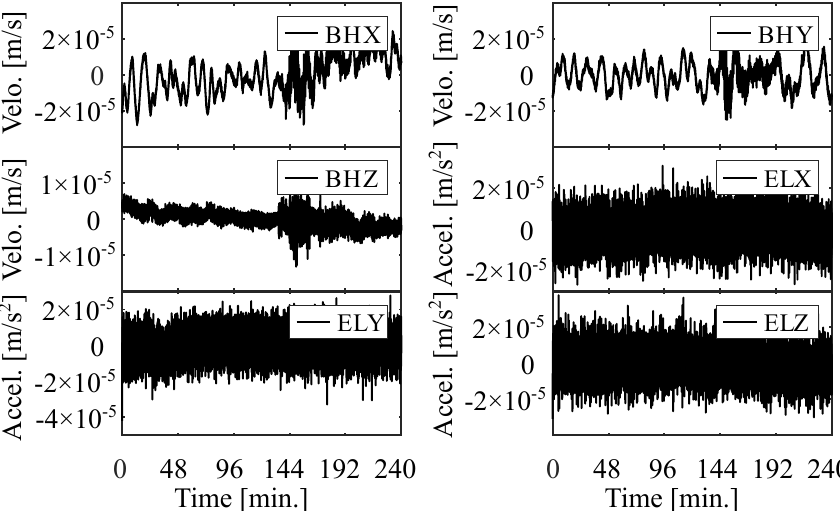
Figure 3. Representative waveforms for the Mie earthquake. The origin of the time is 20:00 on March